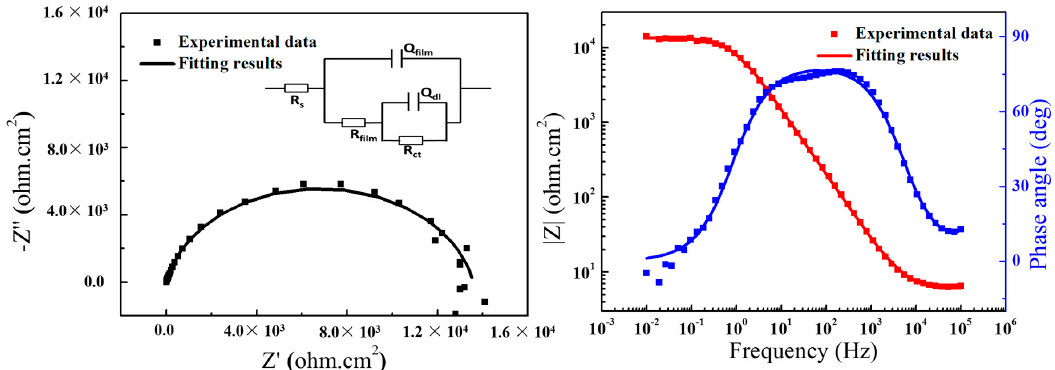
Figure 4. EIS (Electrochemical Impedance Spectroscopy) results of the uncoated aluminum in 3.5% NaCl solution.